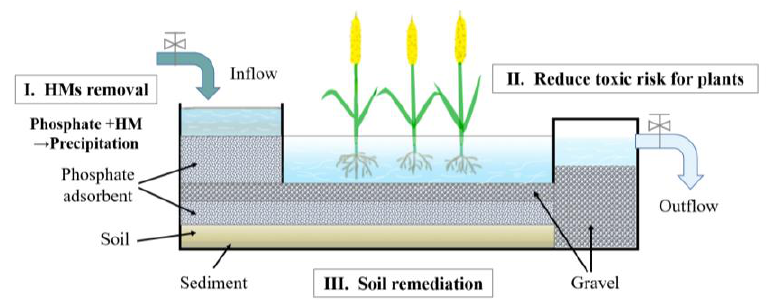
Figure 6. Schematic diagram of phosphates’ potential applications in a constructed wetland system .